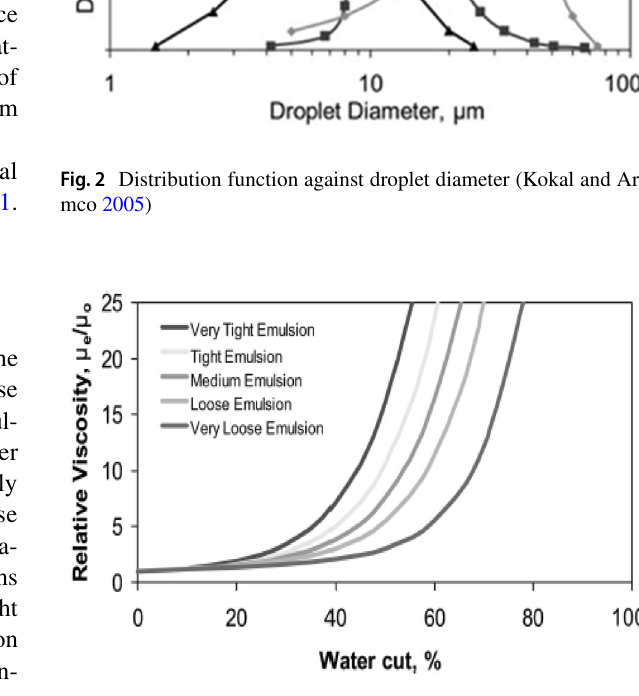
Fig. 3 Relative viscosity against water cut, % (Kokal and Aramco